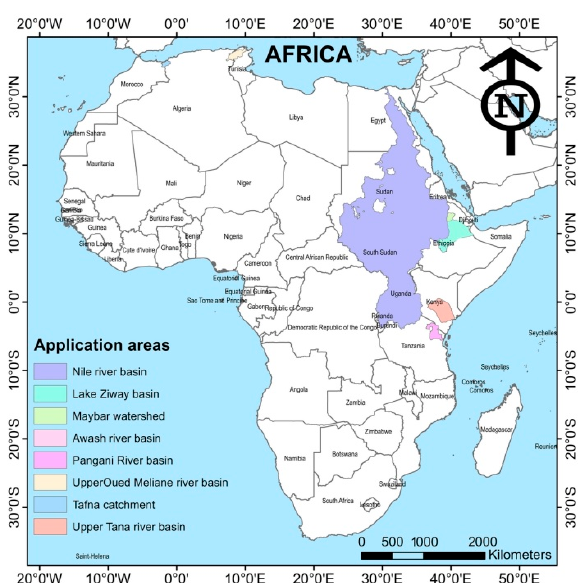
Figure 5. Application areas for studies reviewed considering erosion and sedimentation-related studies in Africa.